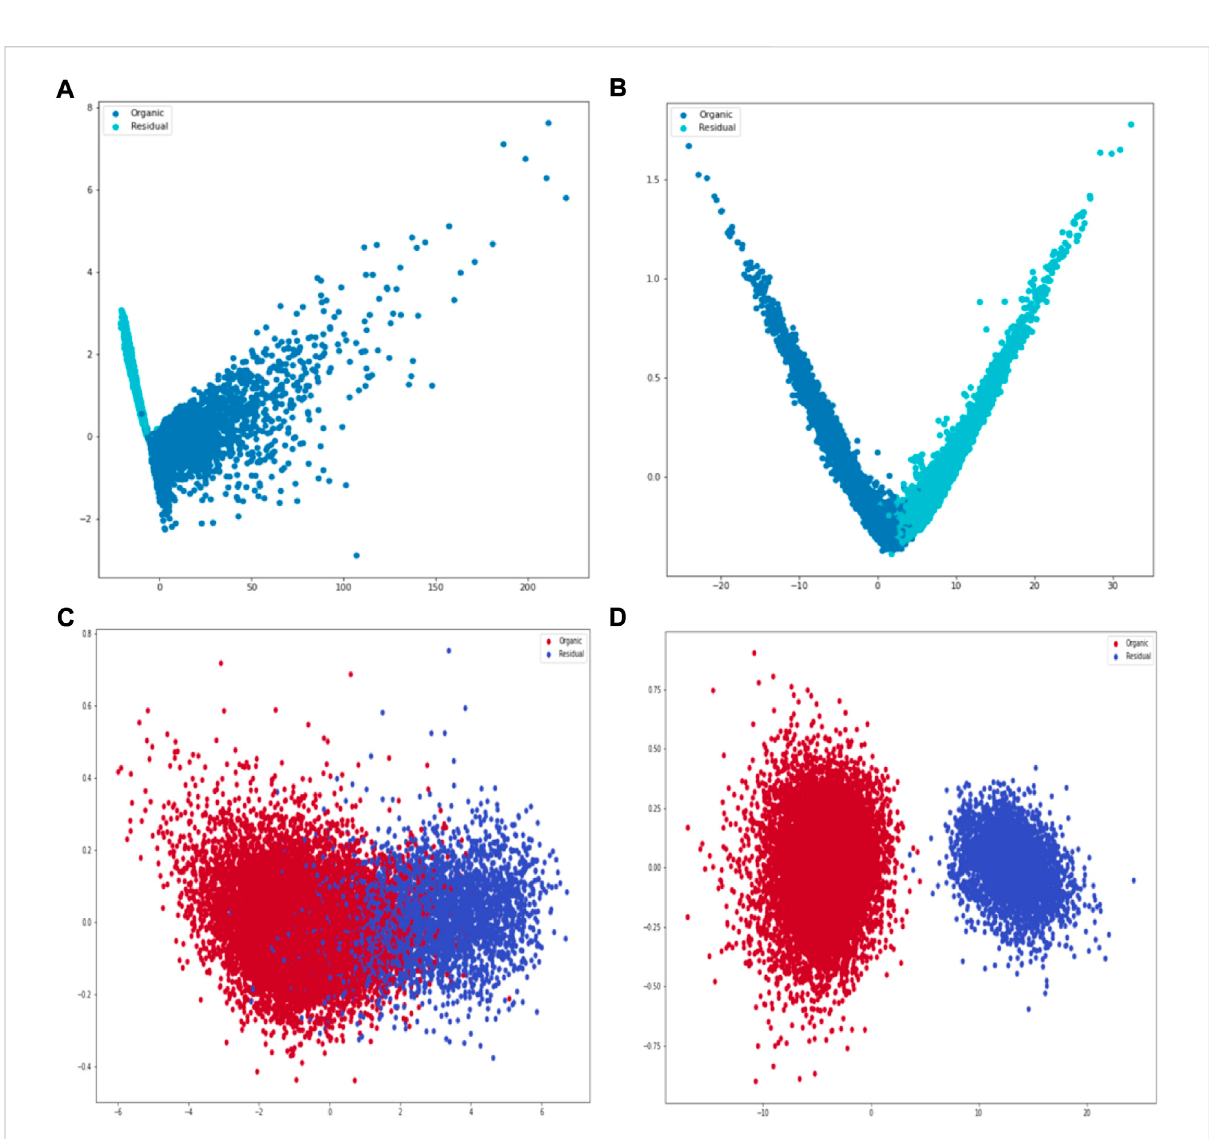
FIGURE 4 A 2-D feature visualization of an image representation of waste images by the method of PCA: (A) VGGNet-16; (B) VGGNet-16 with TL; (C) ResNet-50; (D) ResNet-50 with TL; Note: TL was represented to transfer